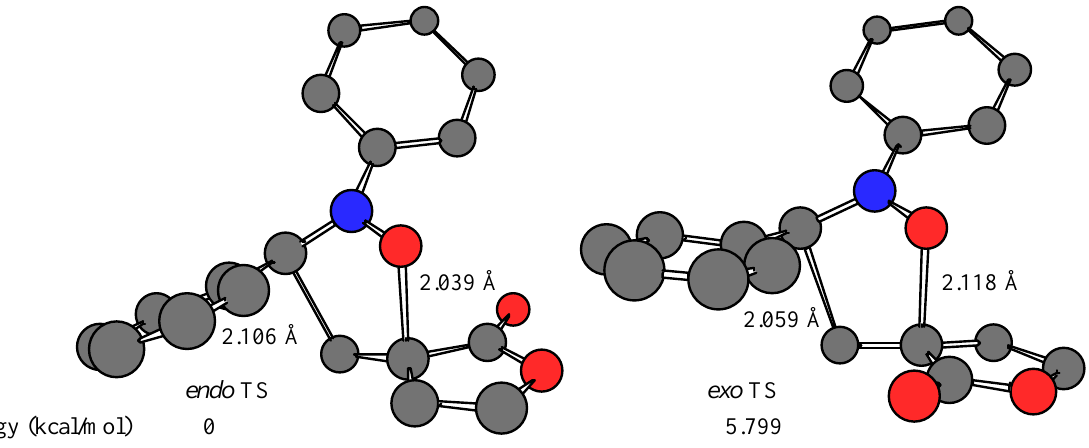
Figure 1. Calculated transition states from nitrone Z - 1 (hydrogen atoms are omitted).